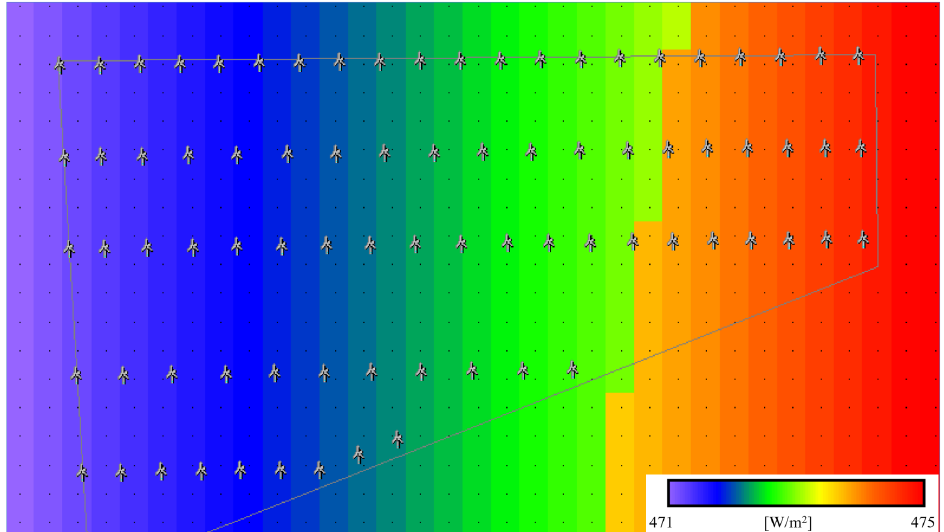
Figure 7. Wind direction rose of 1824#.